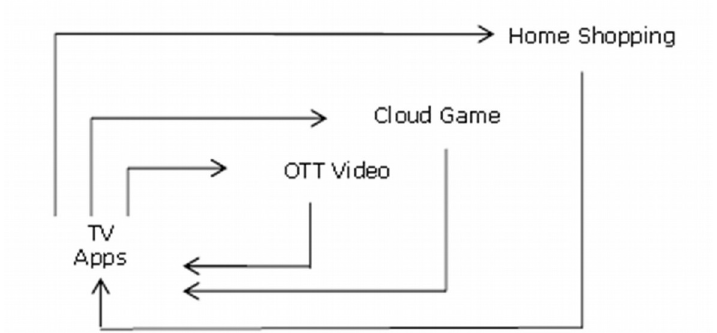
Figure 7. Sample 4 of Home Shopping Initiative